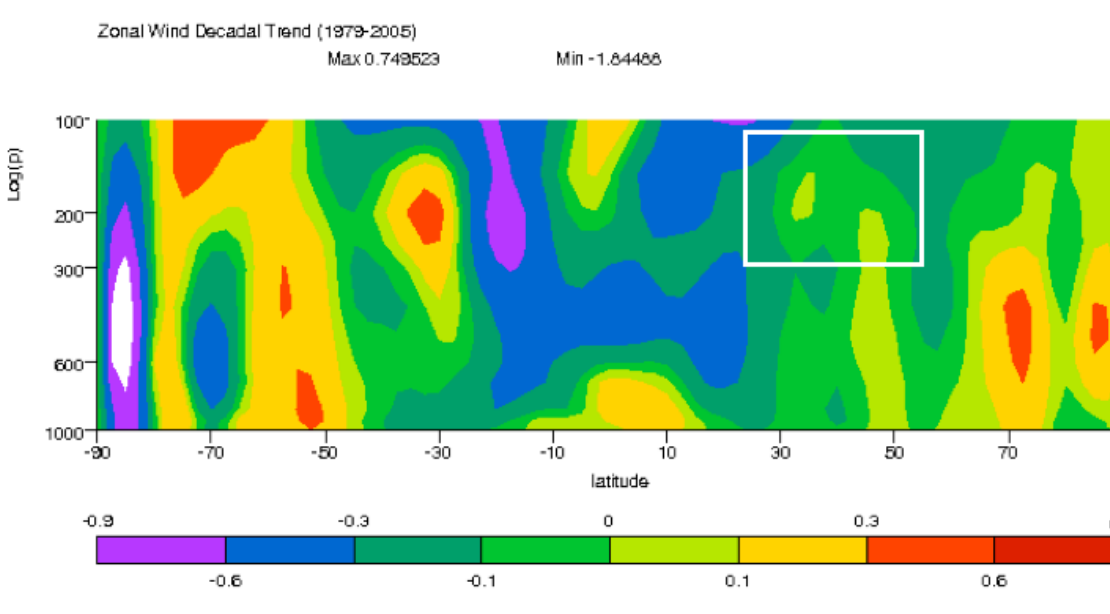
Figure 5. Acceleration of zonal (easterly) wind over the period 1979–2005 as calculated from the globally-complete NCEP Reanalyses. Units are ms −1 decade −1 .